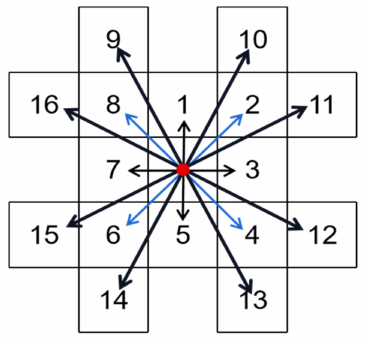
Figure 8. Extended 16